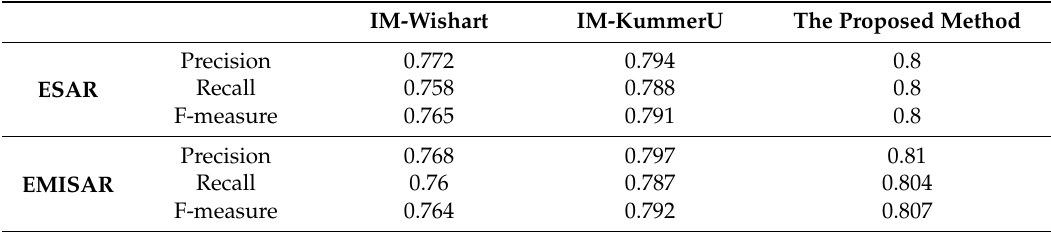
Figure 9. Precision-recall curves of different methods. Table 1. Numerical evaluation measures of the segmentation results using different